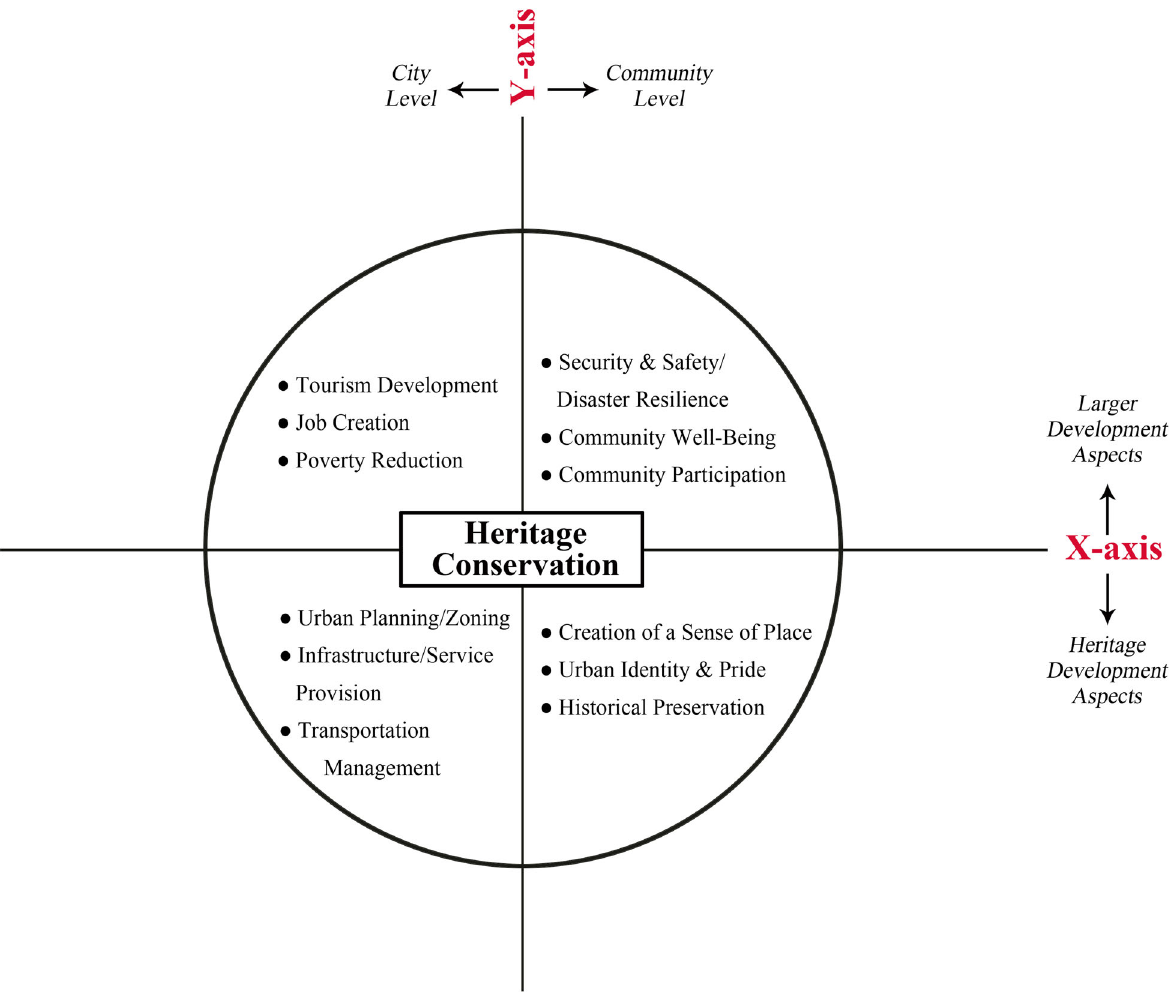
Fig. 8 Heritage conservation policy matrix. (Source: Srinivas 2015; Redrawn by the author